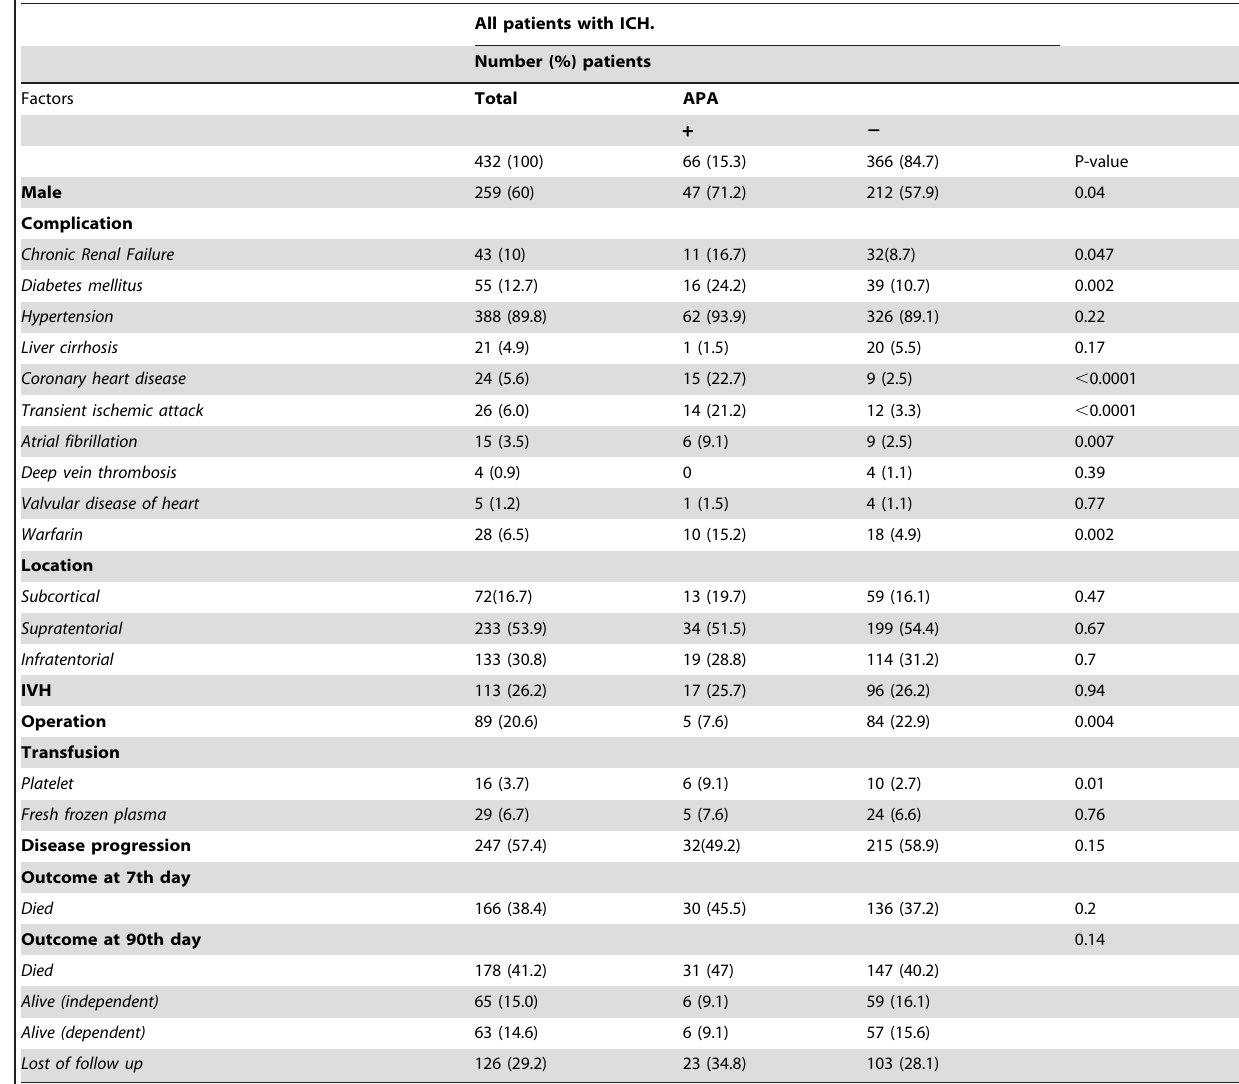
All patients with